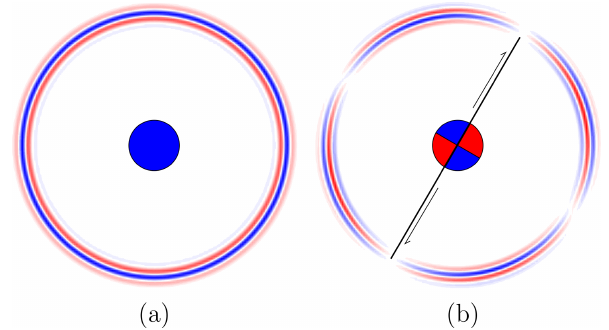
Figure 4. Comparison of the wave fields caused by (a) a monopole point source and (b) a double-couple point source tilted at an angle of 30 ◦ . For both types of sources the radiation pattern of the source is shown in the center. The wave fields have been convolved with a 30Hz Ricker